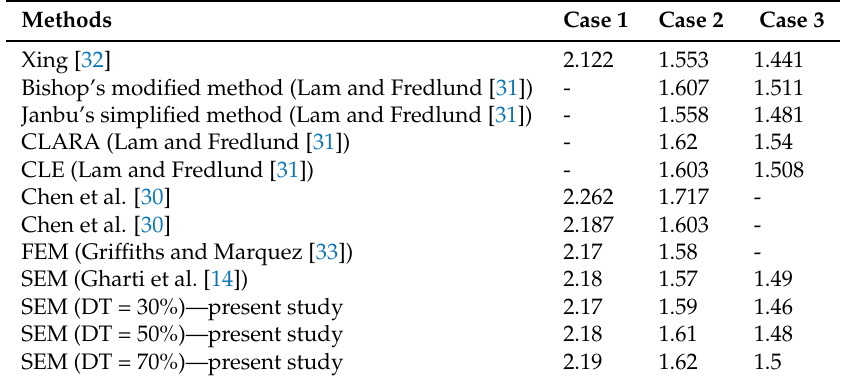
Table 1. Comparison of the safety factor for the three case studies using different